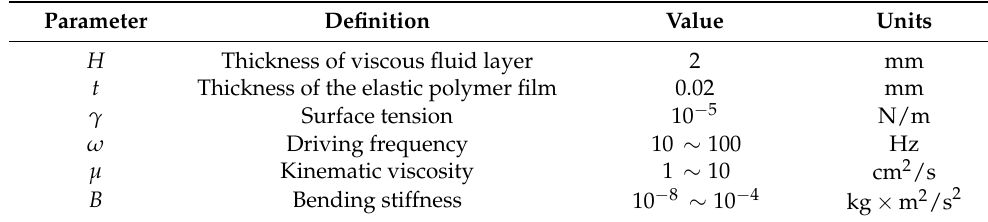
Table 1. Material properties and geometric parameters.